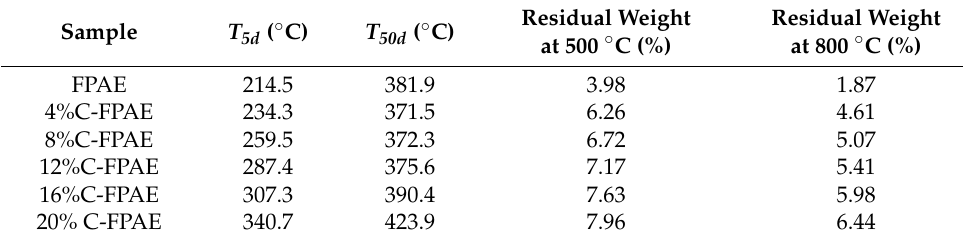
Figure 5. TGA ( a ) and DTG ( b ) curves of FPAE and C-FPAE series with different BDB contents. Table 3. Thermal stability factors of FPAE and C-FPAE obtained from TGA and DTG curves.